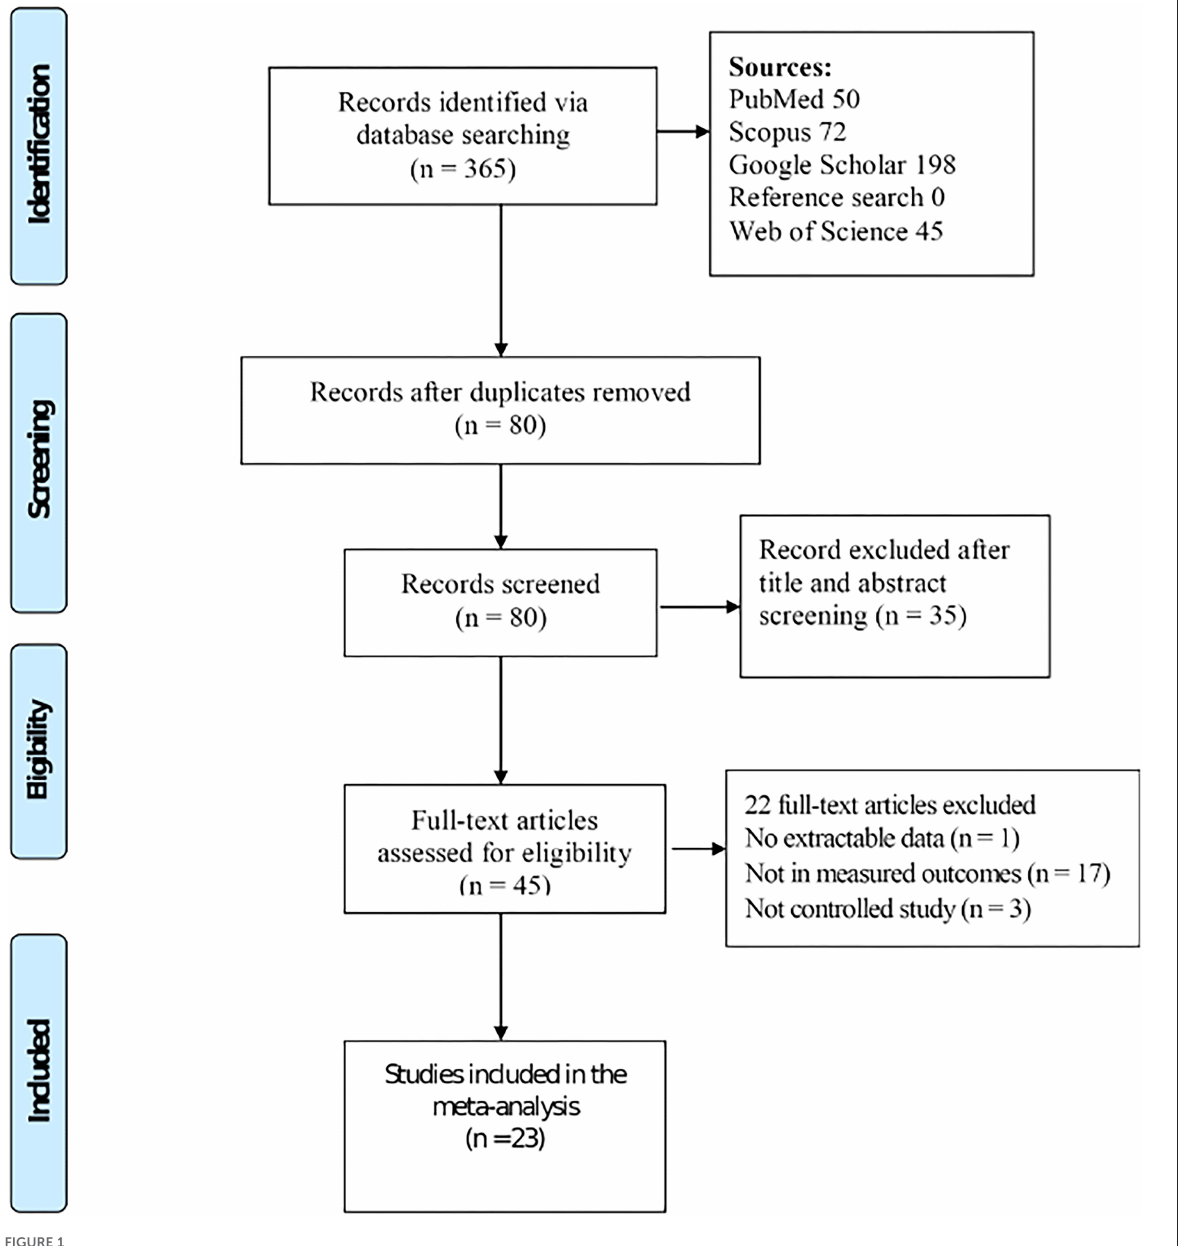
FIGURE1 Study selection flowchart for the meta-analysis.